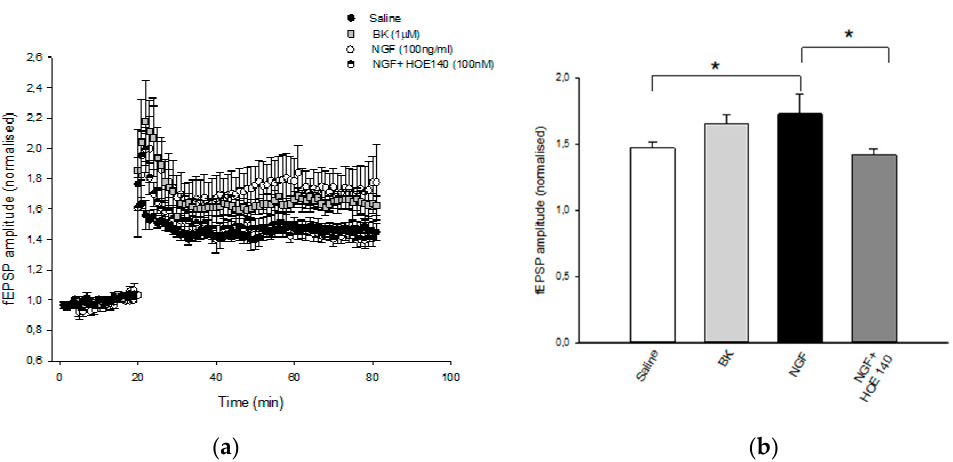
Figure 6. Effect of NGF LTP at CA1 hippocampal synapses. ( a ) Superimposed pooled data showing the normalized changes in field potential amplitude (±SEM) induced by HFS (100 Hz, 1 s). LTP is enhanced following BK (1 μ m) and NGF (100 ng/mL) treatment, and the latter effect is reversed by HOE140 (100 nM) application. At least eight slices from four mice were used for each group tested. ( b ) Histograms show the relative increase in the fEPSP amplitude measured 50–60 min post-HFS under the different pharmacological conditions (* p < 0.05).